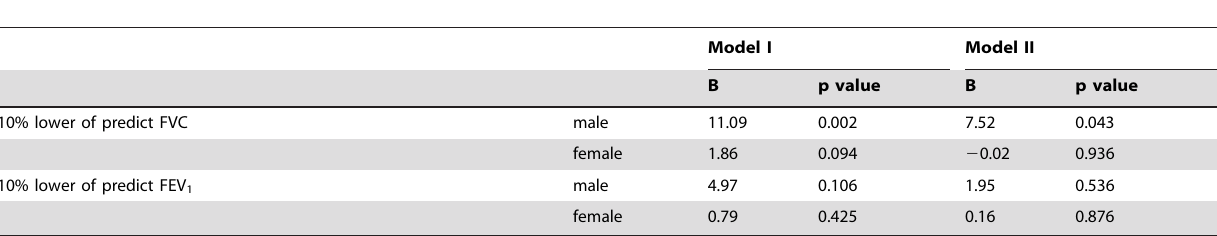
Table 2. Multivariate regression analyses for urine albumin/creatinine ratio by pulmonary